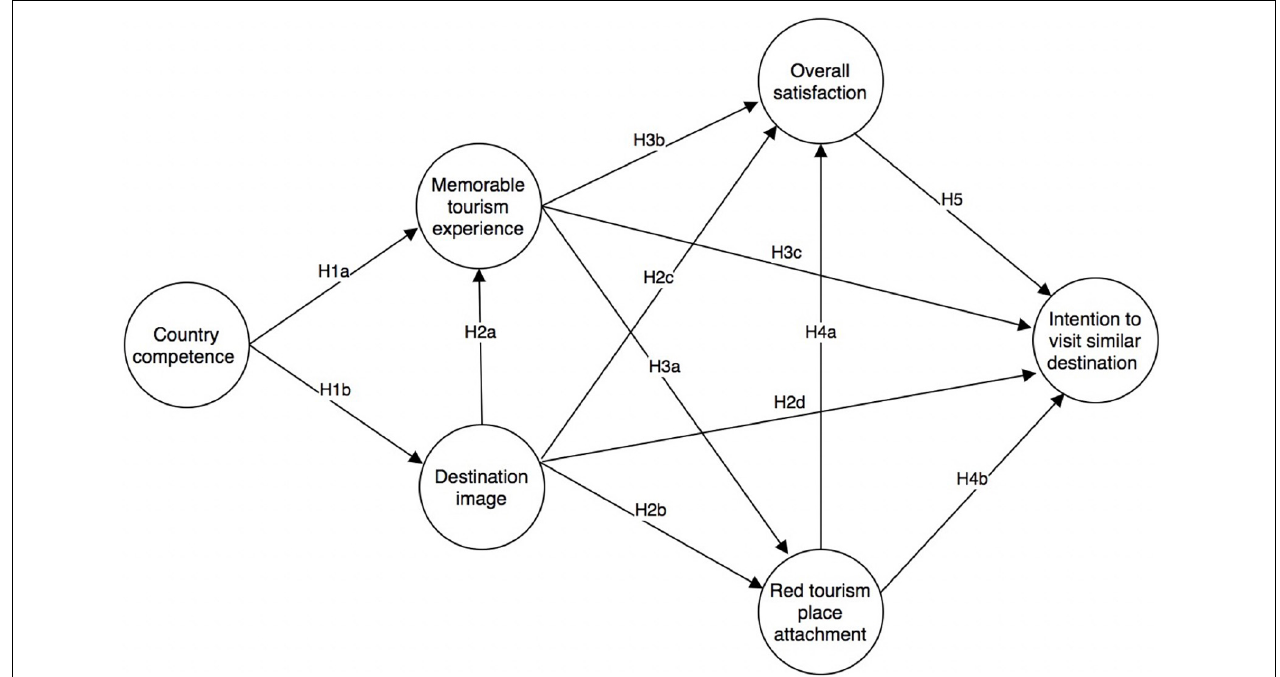
FIGURE 1 | Conceptual